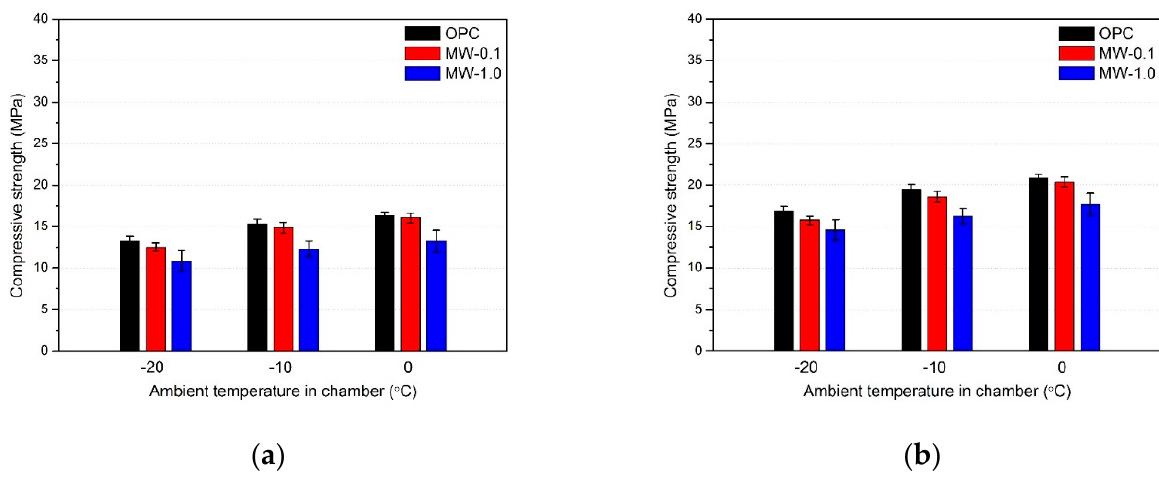
Figure 9. Compressive strength of the specimens without the insulation box after ( a ) 7 days and ( b ) 28 days.